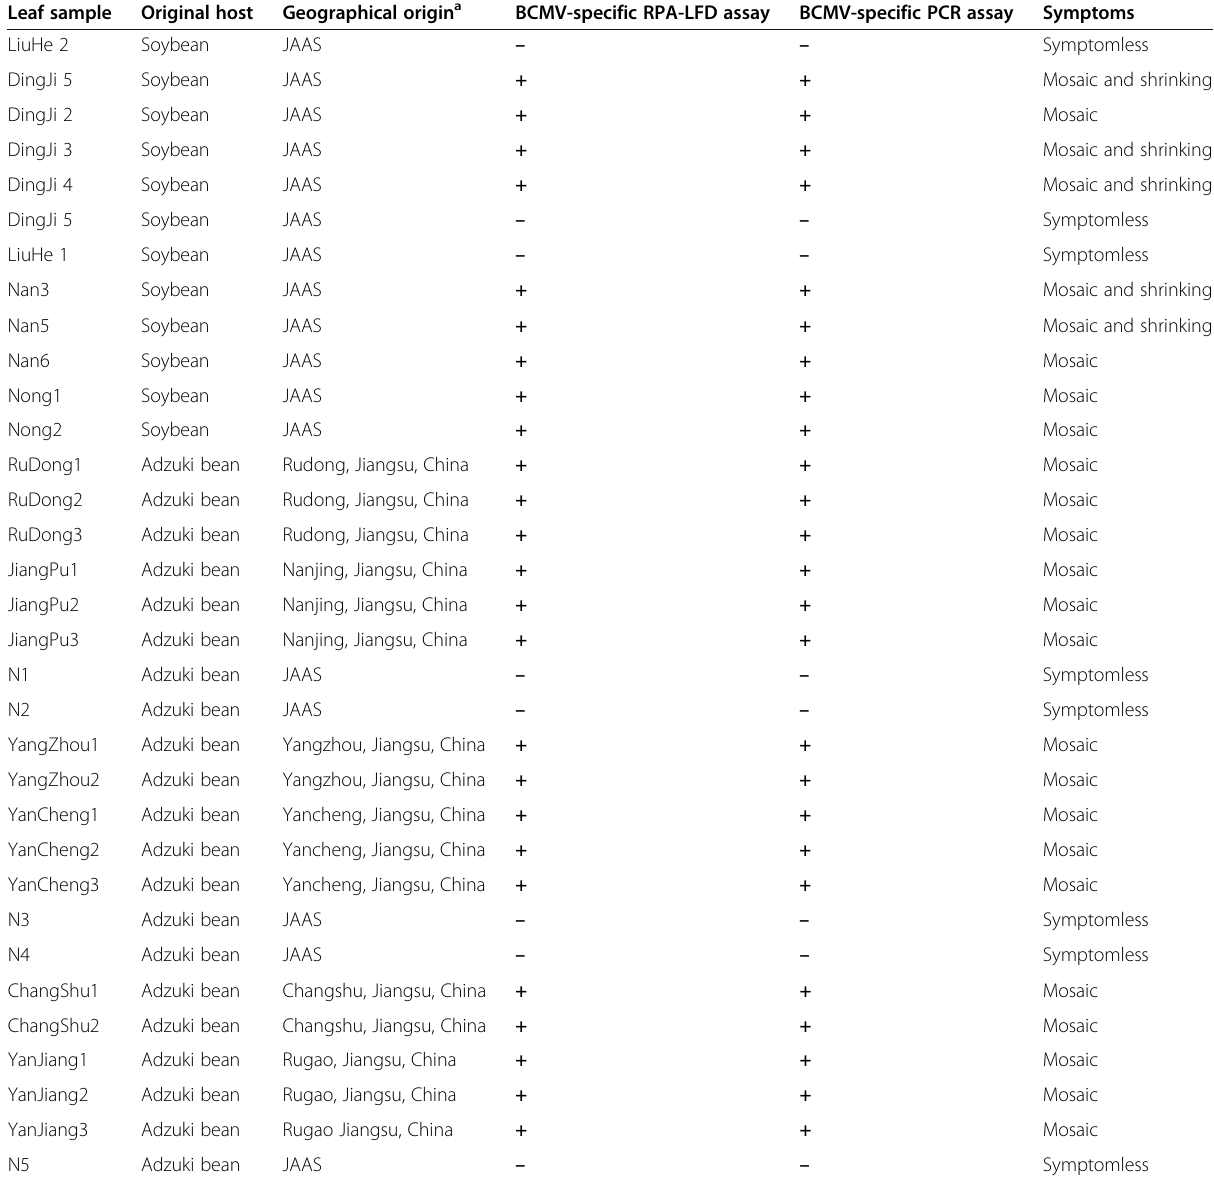
Table 1 Detection results by RPA-LFD for BCMV in soybean and adzuki bean samples from different regions of Jiangsu Province,